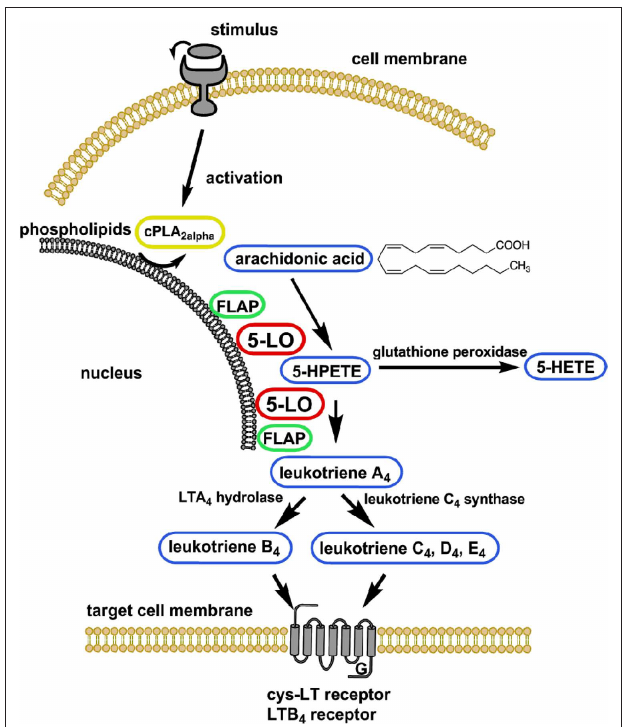
Figure 1 | Schematic of leukotriene biosynthesis. For detailed description see Section 5-Lipoxygenase is a Key Enzyme in Leukotriene Biosynthesis. cPLA , cytosolic phospholipase A ; 5-HETE, 5( S )-hydroxy-8,11,14-cis-6- 2alpha 2alpha trans-eicosatetraenoic acid; 5-HPETE, 5( S )-hydroperoxy-6-trans-8,11,14-cis- eicosatetraenoic acid; 5-LO, 5-lipoxygenase; FLAP, 5-lipoxygenase-activating protein; LT,